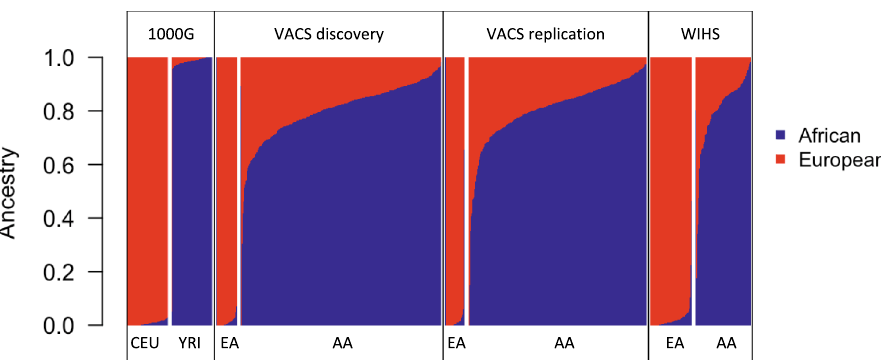
Fig. 1 Global ancestry estimated using ADMIXTURE for African Americans and European Americans in the Veterans Aging Cohort Study (VACS) discovery group, VACS internal replication group, and the Women ’ s Interagency HIV Study (WIHS) external replication group. Yoruba in Ibadan, Nigeria (YRI) and Utah Residents (CEPH) with Northern and Western European Ancestry (CEU) samples from the 1000 Genomes Project are used as the African and European reference panels.